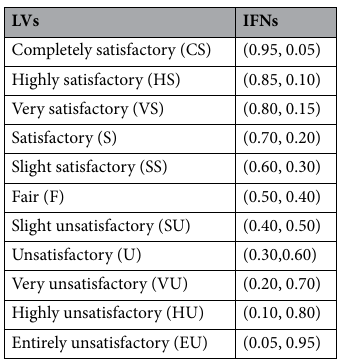
Table 3. LVs for performance ranking of options.